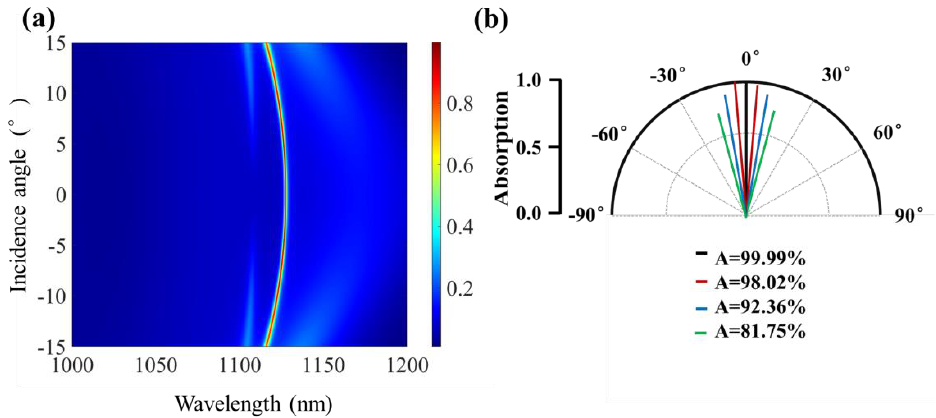
Figure 9. ( a ) Absorption spectrum of the graphene absorber versus the angle of incidence and wavelength. length. ( b ) Absorption angular pattern at seven different incident angles θ = 0